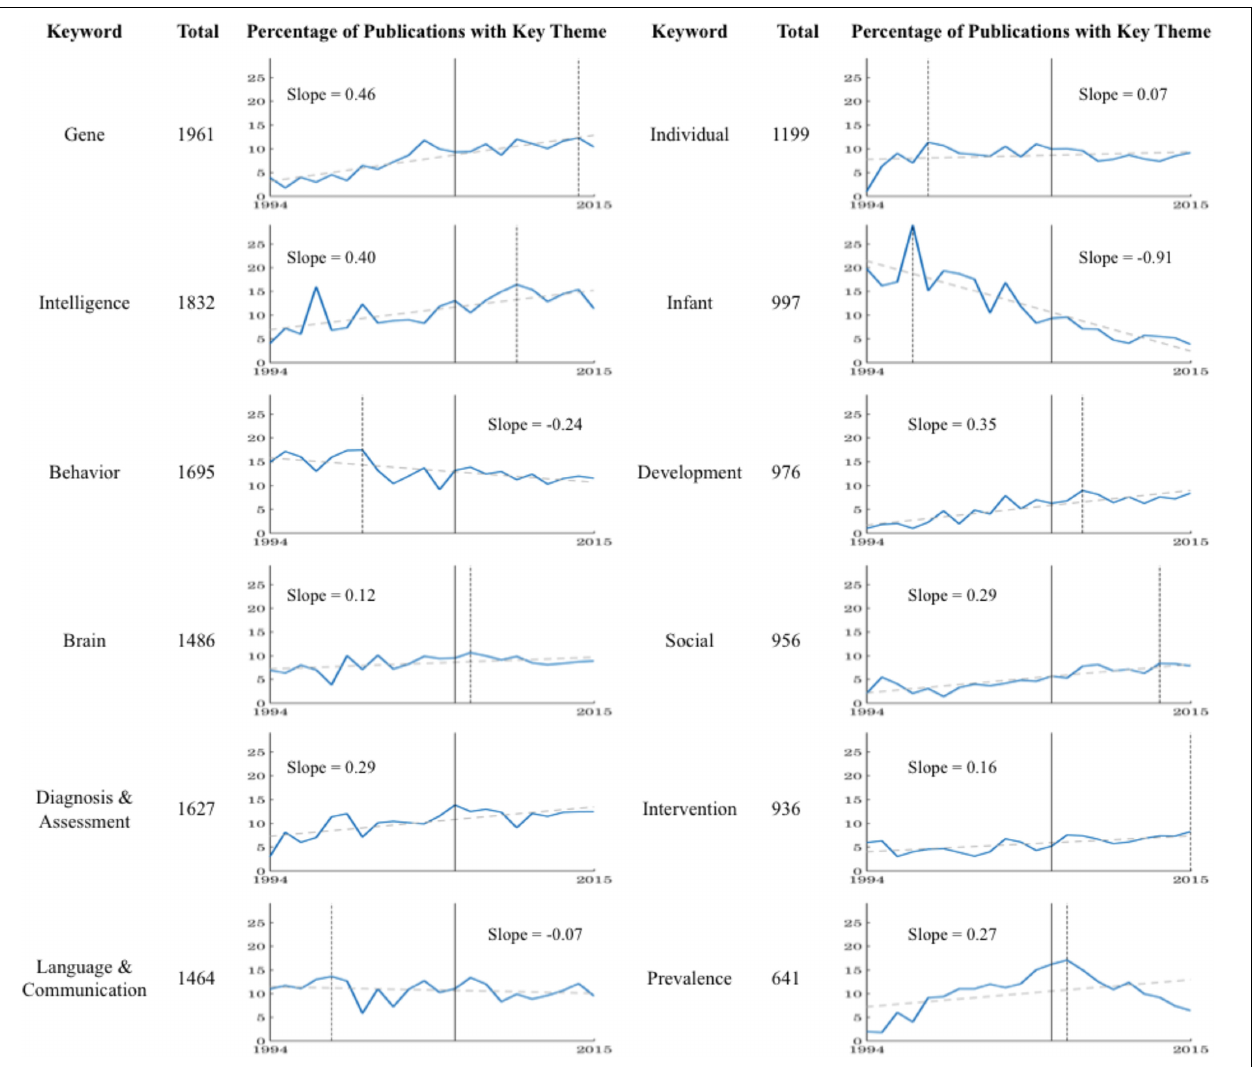
FIGURE 7 | Systematically profiling and tracking of 12 prominent keyword/themes across the corpus. The count of each theme within the maximal nodes per year was isolated, and transformed into a percentage of the total year publications – providing a standardized metric. The inflection year (2006; see Figure 2 ), and the year of maximal occurrence for that theme (as denoted by the dashed vertical line) are referenced for contextual understanding. In addition, a line of best fit is empirically derived and illustrated for each theme, demonstrating the continued growth across the academic arena for all themes with the exception of Infant, Behavior and Language and Communication. For larger high resolution figures please see